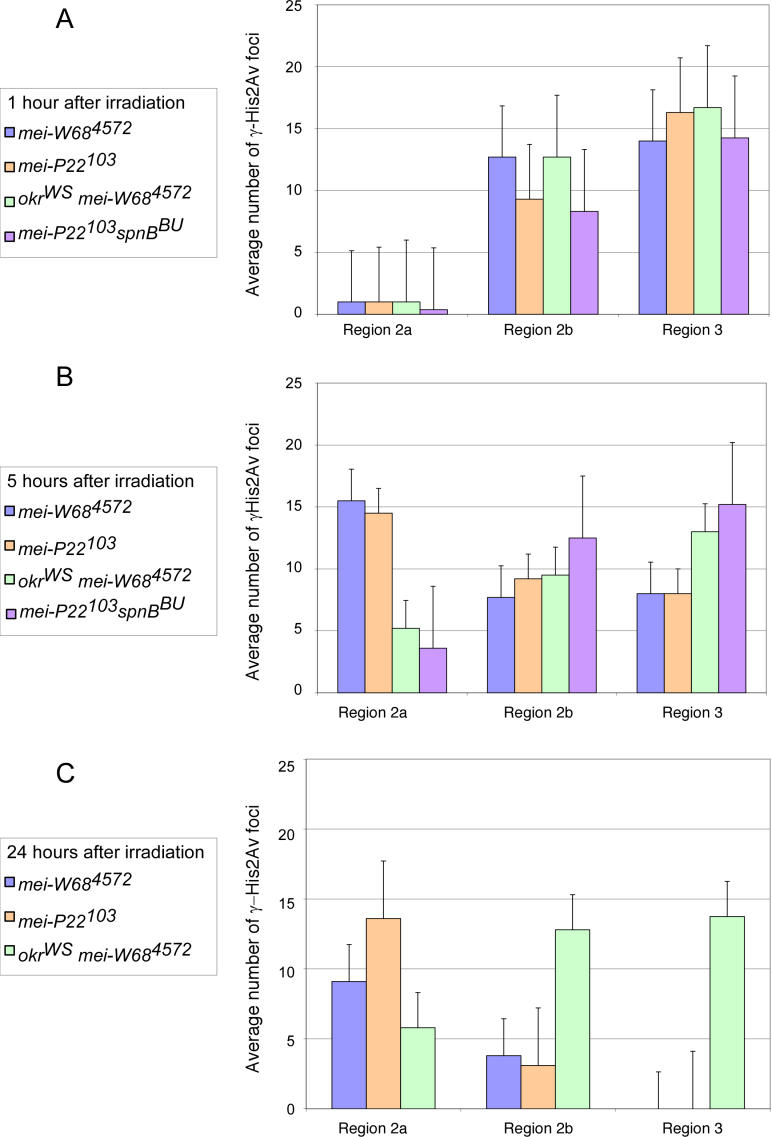
Frequency of γ-His2Av Foci Induced with 10 Gy of X-Rays as a Function of Meiotic Stage and Time since ExposureAverage number of γ-His2Av foci observed in mei-W684572 (blue), mei-P22103 (orange), okrWS mei-W684572 (green), and mei-P22103 spn-BBU (purple) at 1 h (A), 5 h (B), and 24 h (C) after irradiation. In region 2a pro-oocytes 5 h after irradiation, okrWS mei-W684572 pro-oocytes had 24.8% of the γ-His2Av foci found in mei-W684572, and mei-P22103 spn-BBU had 33.6% of the foci found in mei-P22103. Data for the 24-h timepoint in mei-P22103 spn-BBU was not collected.